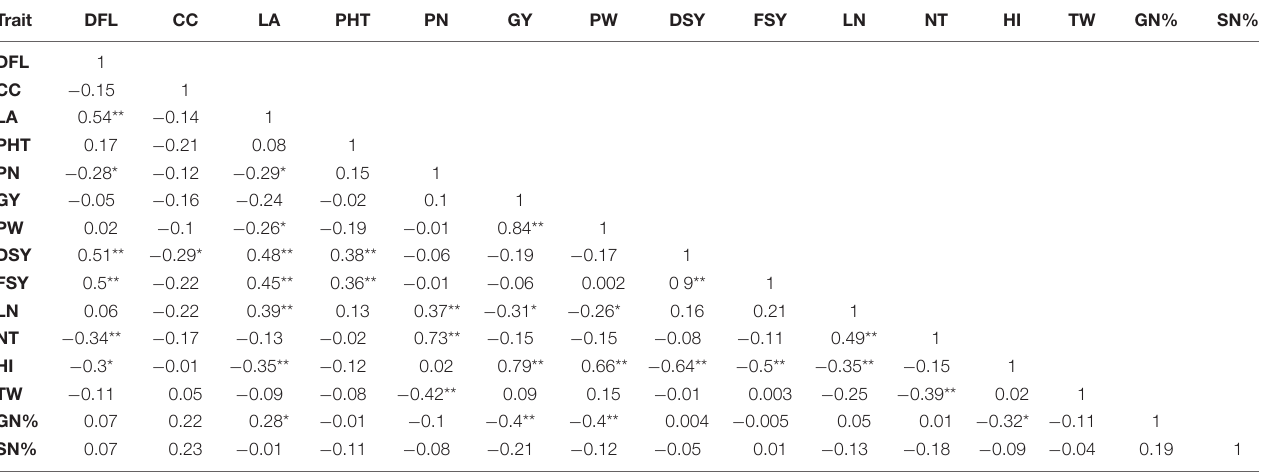
TABLE 5 | Correlation coefficient analysis of 60 genotypes for different traits at N100 condition across seasons.